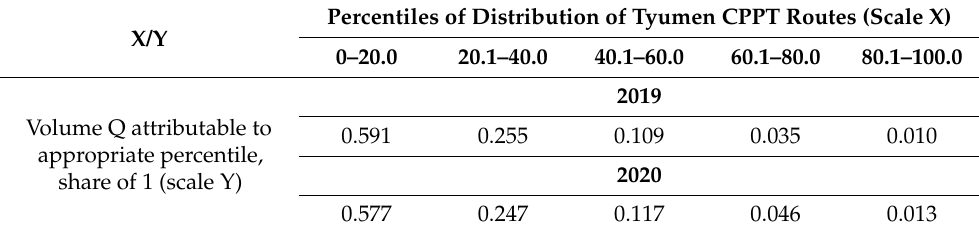
Table 11. Distribution of annual transportation volume Q 04–06 by percentiles of Tyumen CPPT routes.